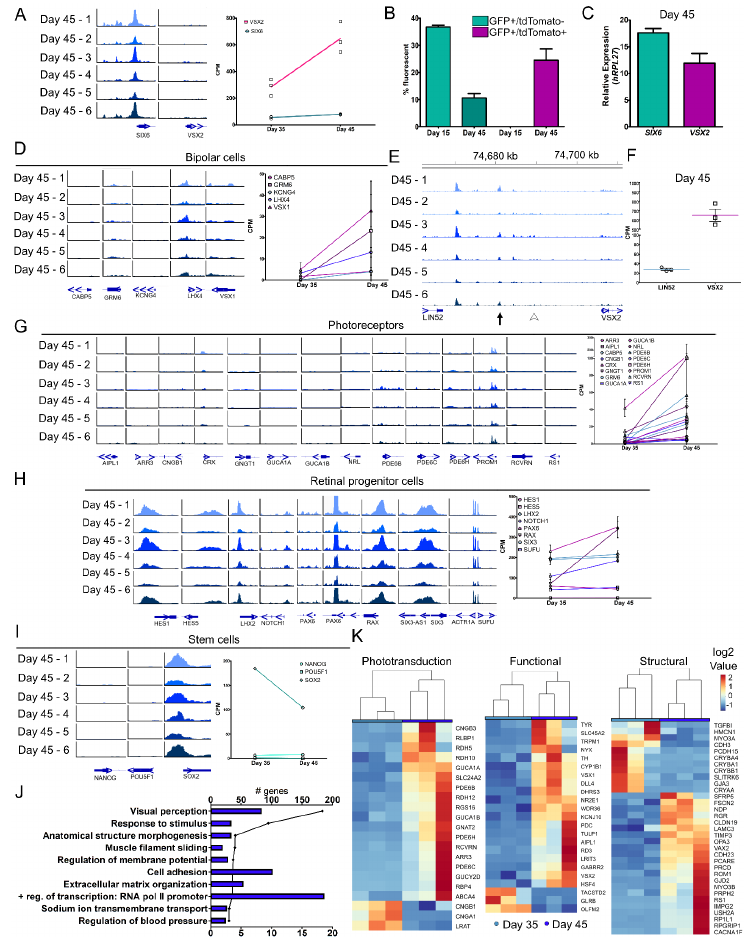
Figure 4. Molecular changes in retinal organoids at the juncture of retinal cell specification. ( A ) Genomic tracks for individual day 45 organoids at the TSS of SIX6 and VSX2 (left) and the corre- sponding RNA-seq values of day 35 and 45 (right). ( B ) Flow cytometry was performed at days 15 and 45 for GFP and tdTomato. No tdTomato+ cells were detected at day 15, and at day 45 all tdTomato+ cells additionally were GFP+. ( C ) qRT-PCR for SIX6 and VSX2 mRNA expression at day 45 was performed. ( D ) Genomic tracks (left) and mRNA expression (right) of bipolar cell genes. ( E ) Genomic region upstream of VSX2 from day 45 ATAC-seq samples. The location of published core regulatory circuit super enhancer (CRC-SE, Diri et al.) are indicated by black arrows and the location of proximal promoter elements (Kim et al., arrowhead) are indicated by white arrowheads. ( F ) A scatter plot showing corresponding values from RNA-seq of VSX2 and the upstream gene LIN52 (right). ( G ) Ge- nomic tracks (left) and mRNA expression line graphs (right) of characteristic photoreceptor markers. ( H ) Genomic tracks (left) and corresponding mRNA expression line graphs (right) for retinal pro- genitor cell markers. ( I ) Genomic tracks (left) and mRNA expression line graphs (right) from day 45 samples for stem cell markers. ( J ) A bar graph showing the number of genes involved in each pathway and a line graph depicting the –log(Benjamini-Hochberg) for the 10 statistically significant pathways ( − log(Benjamini-Hochberg) > 3) as determined by DAVID (Table S5). ( K ) “Visual perception” was the most highly significant pathway and was further classified into phototransduction, functional, and structural genes and heatmaps were generated. Scale for all genomic tracks =